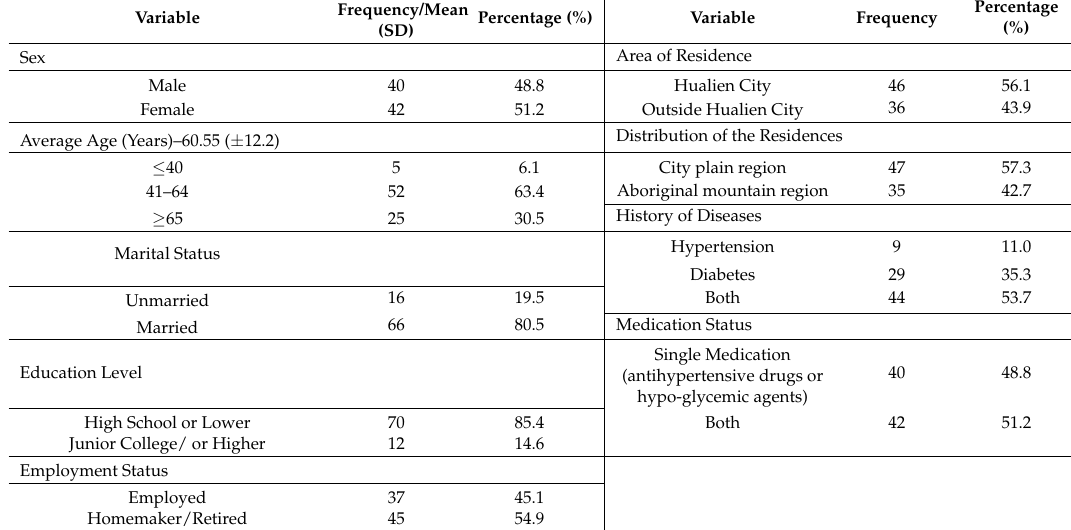
Table 1. Demographics (N = 82).